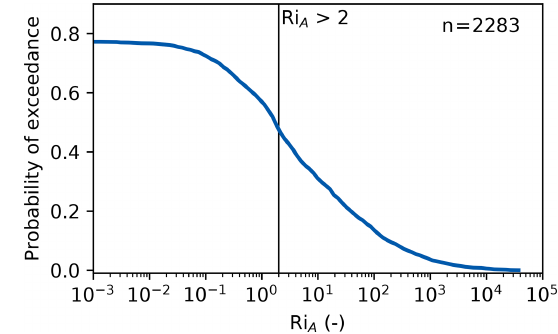
Figure 6. Cumulative probability distribution of the convective ris- ing height of a parcel of warm air from forest floor.